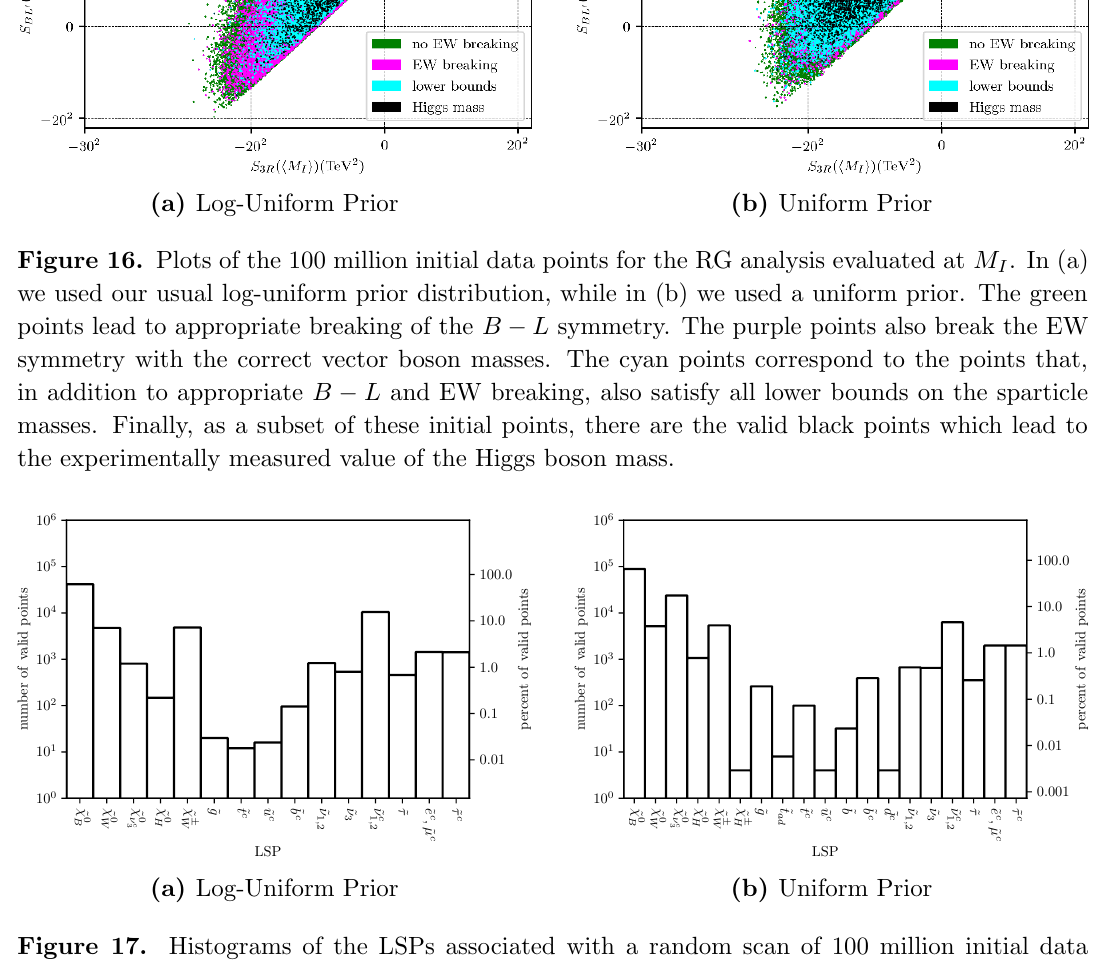
Figure 17. Histograms of the LSPs associated with a random scan of 100 million initial data points, showing the percentage of valid black points with a given LSP. In (a) we used our usual log- uniform prior distribution, while in (b) we used a uniform prior. Sparticles which did not appear as LSPs are omitted. The y-axis has a log scale. The notation and discussion of the sparticle symbols on the x-axis were presented in